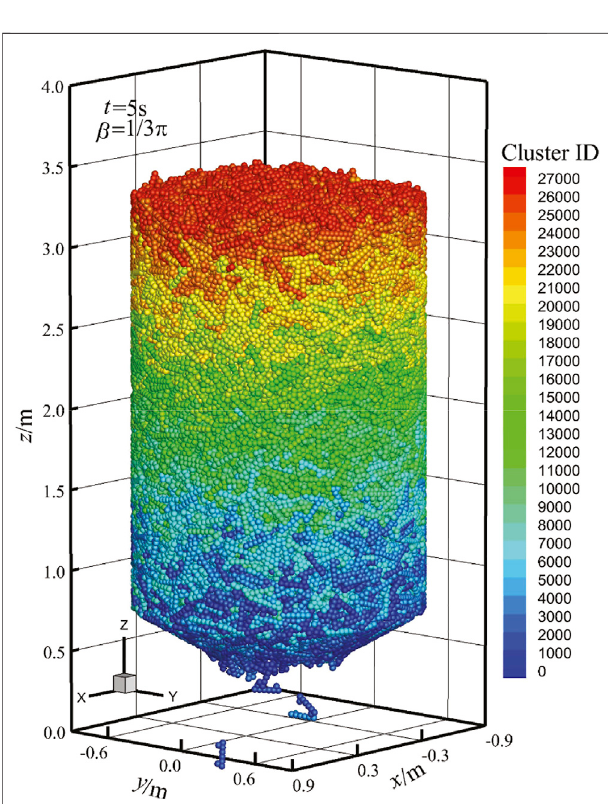
FIGURE 3 | Snapshots of particle discharge when aspect δ (cid:1) 2:6, β (cid:1) π /3 at t (cid:1) 5